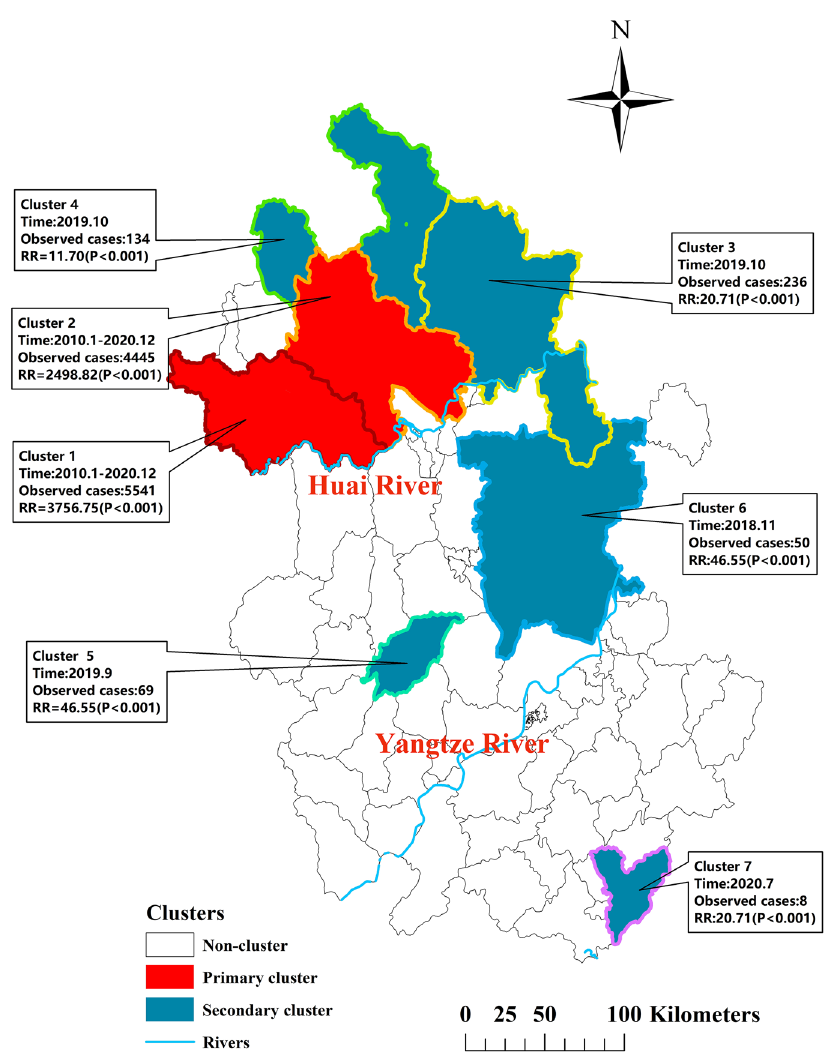
Figure 6. Spatiotemporal clusters of scrub typhus cases at the county level across the period of 2010–2020 in Anhui, China. The base layer of the map was obtained from Resource and Environment Science and Data Center (https:// www. resdc. cn/ Datal ist1. aspx? Field TyepID=